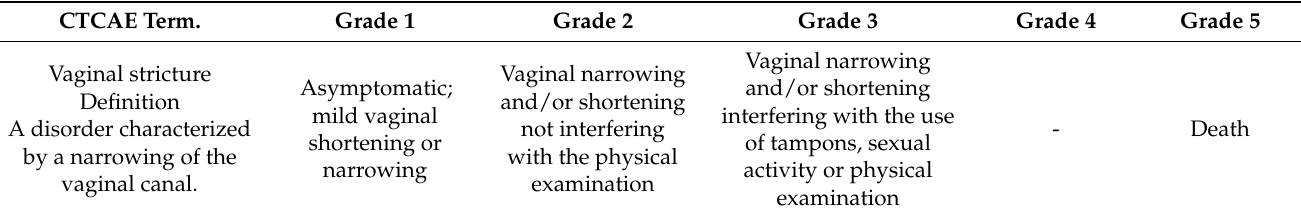
Table 1. Common terminology criteria for adverse events (CTCAE) for vaginal stricture. Version 5.0. CTCAE Term.